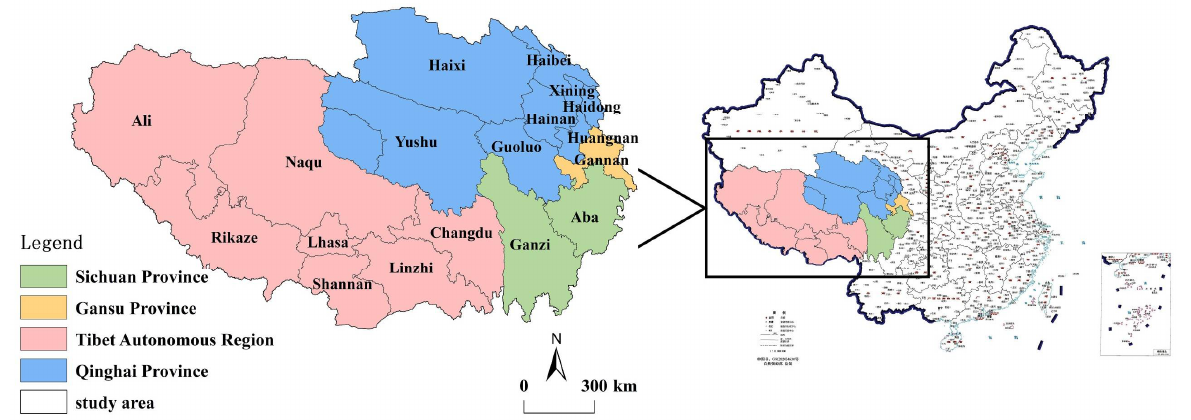
Figure 1. The 18 cities on the Tibetan Plateau (source: GS(2020)4630).